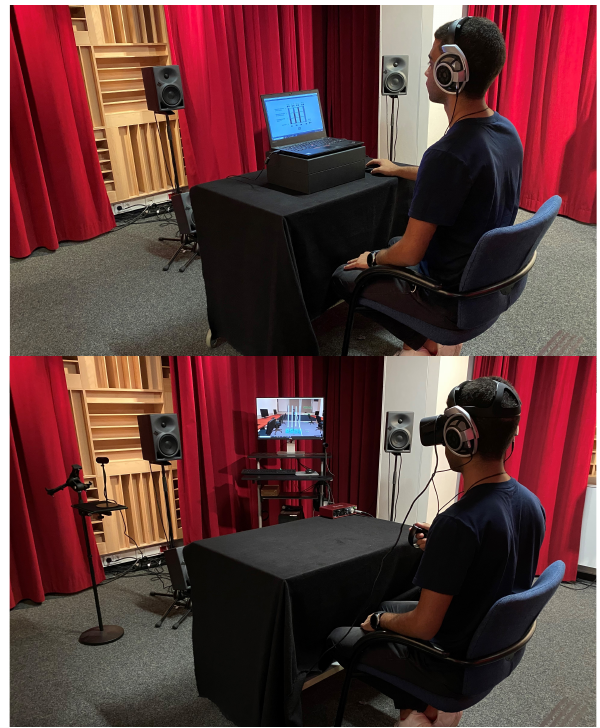
Figure 1. Photographs of the experimental setups for performing desktop ( top )- and VR ( bottom )- based listening experiments.